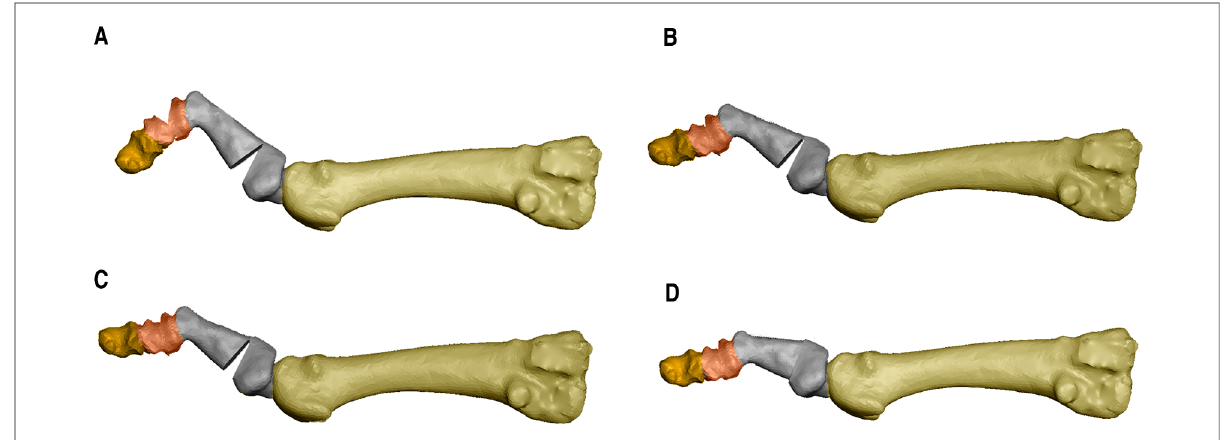
FIGURE 2 ( A ) design of a double osteotomy of the proximal phalanx at proximal and distal level and an osteotomy of the middle phalanx in case of claw toe; ( B ) closing of the middle phalanx osteotomy; ( C ) closing of the distal osteotomy of the proximal phalanx; ( D ) closing of the proximal osteotomy of the fi rst phalanx with complete reduction of the